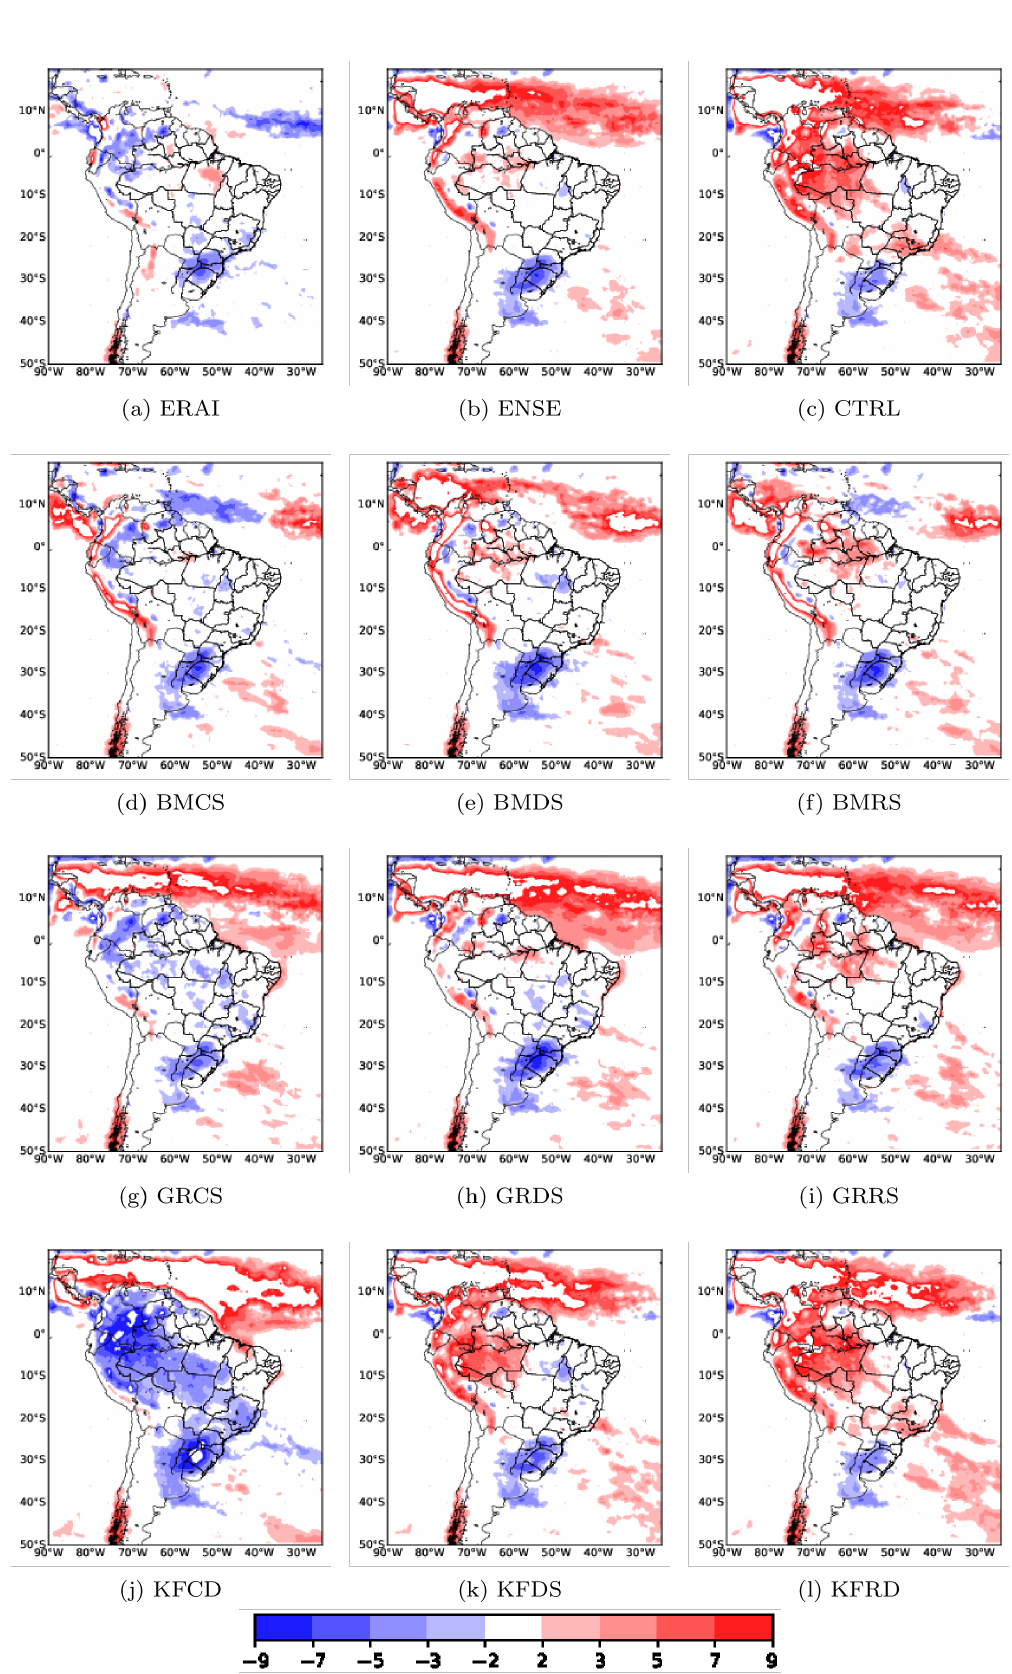
Figure 10. As in Figure 7, but for September–October–November